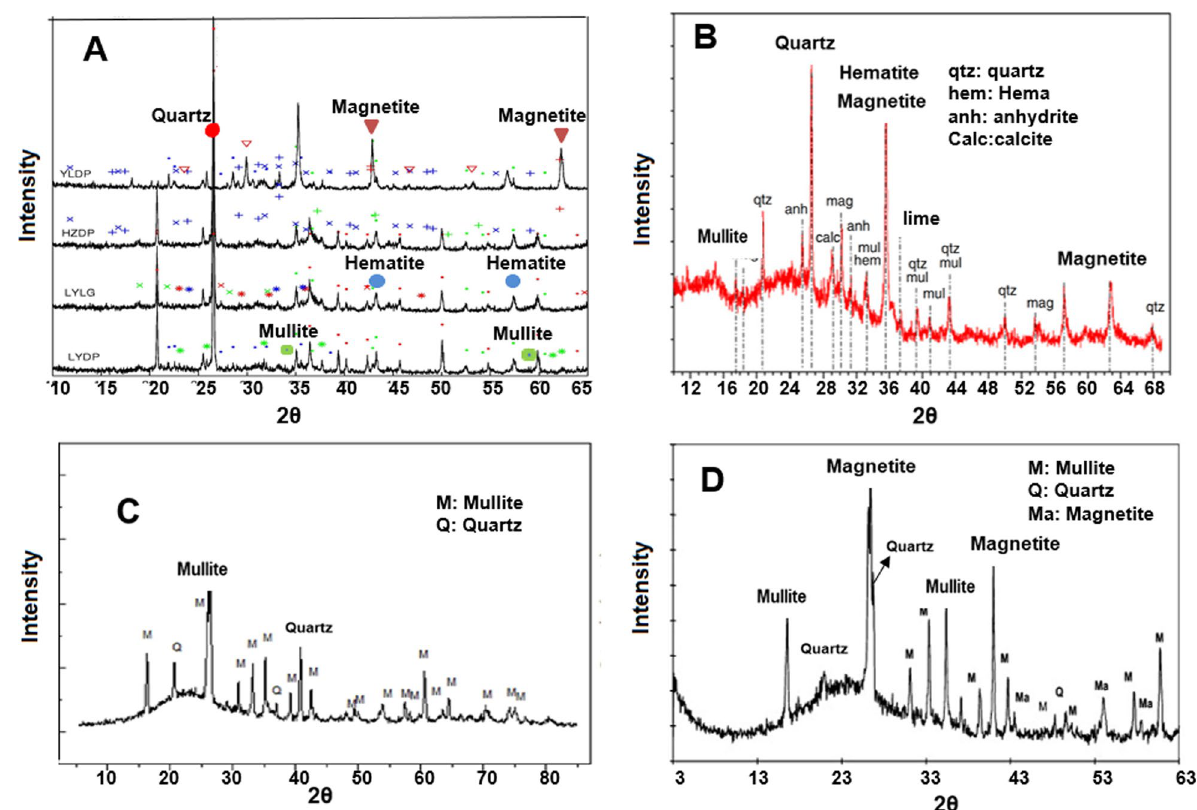
Fig. 4 Comparison of the XRD images of four CFAs from different reports a Australian brown coal fly (Tennakoon et al. 2015); b Ther- mal coal power plant Germany (Li et al. 2016); c Circulating fludized